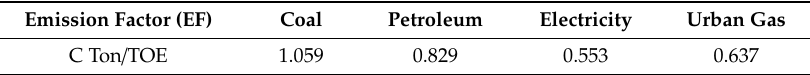
Table 2. Carbon emission